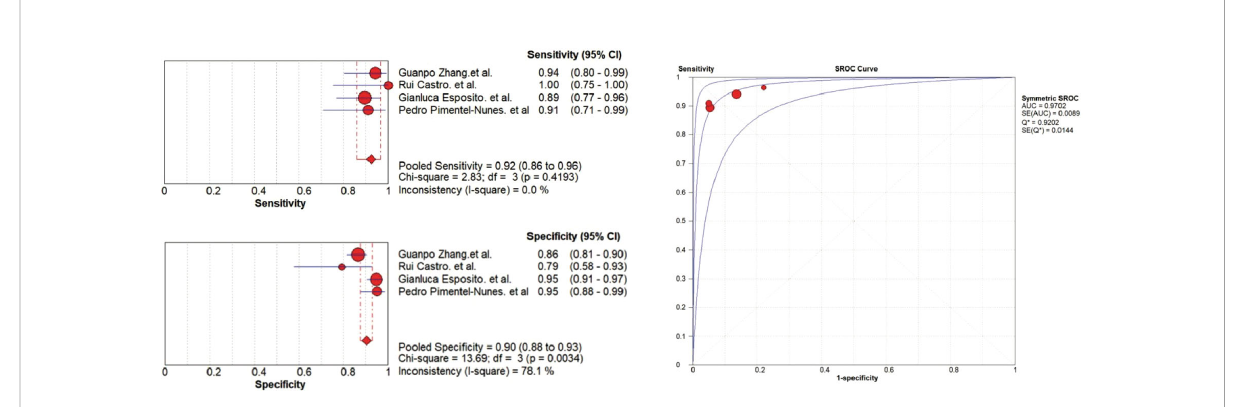
FIGURE 2 Diagnostic accuracy analysis of EGGIM(5-10) compared to OLGIM